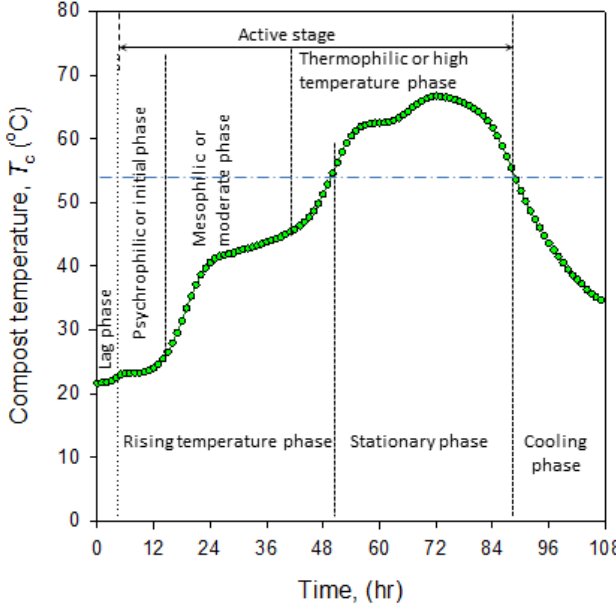
Figure 9. Composting phases were outlined based on the measured temperature of compost ( T c ) in the present